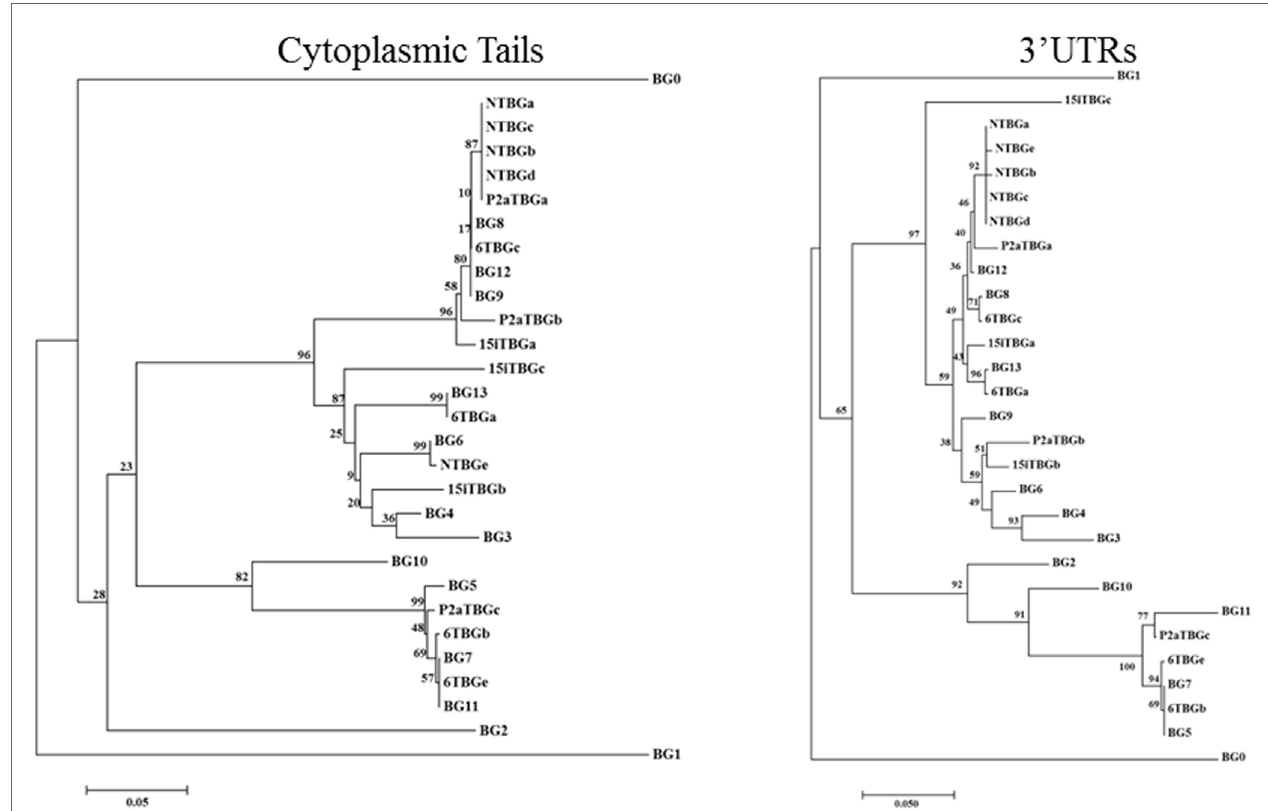
FigUre 4 | Phylogenetic trees of nucleotide sequences for portions of the “(nearly) full-length conceptual transcripts” (i.e., exons without introns) for the 16 genes (based on exon 2 sequences) from four chicken lines identified in this paper, and for the 14 BG genes of the B12 haplotype from Ref. (24). Trees include 5 ′ untranslated region (5 ′ UTR) from exon 1, signal sequence from exon 1, exon 2 (two nucleotides from the signal sequence and then the nucleotides encoding the Ig-V domain), exon 3 (transmembrane region), the exons corresponding to the cytoplasmic tail (excluding any nucleotides in the final exon that encode amino acids), and the final exon [which is exactly the 3 ′ untranslated region (3 ′ UTR) in some sequences, but for which the first nucleotides encode the last amino acids of the cytoplasmic tail in most sequences]. Other details are in the Figure 3